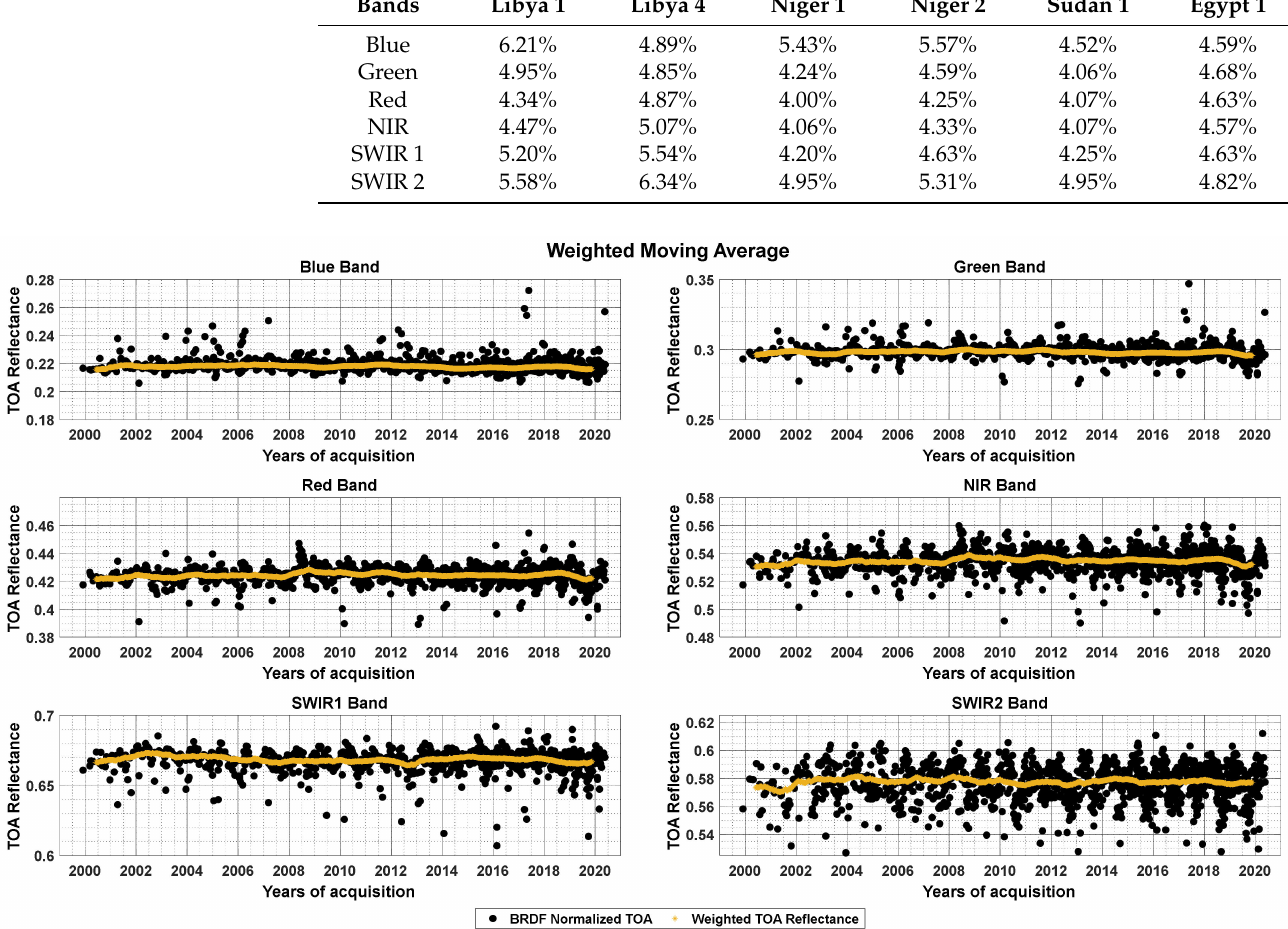
Figure 5. Weighted moving averaged TOA reflectance data of the virtual constellation over Sudan 1 for blue, green, red, NIR, SWIR 1, and SWIR 2